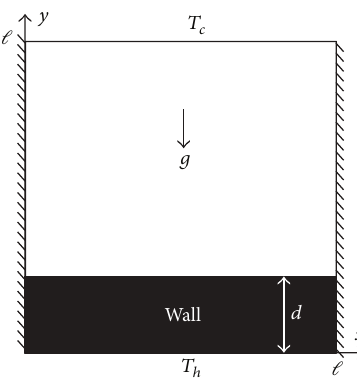
Figure 1: Schematic representation of the